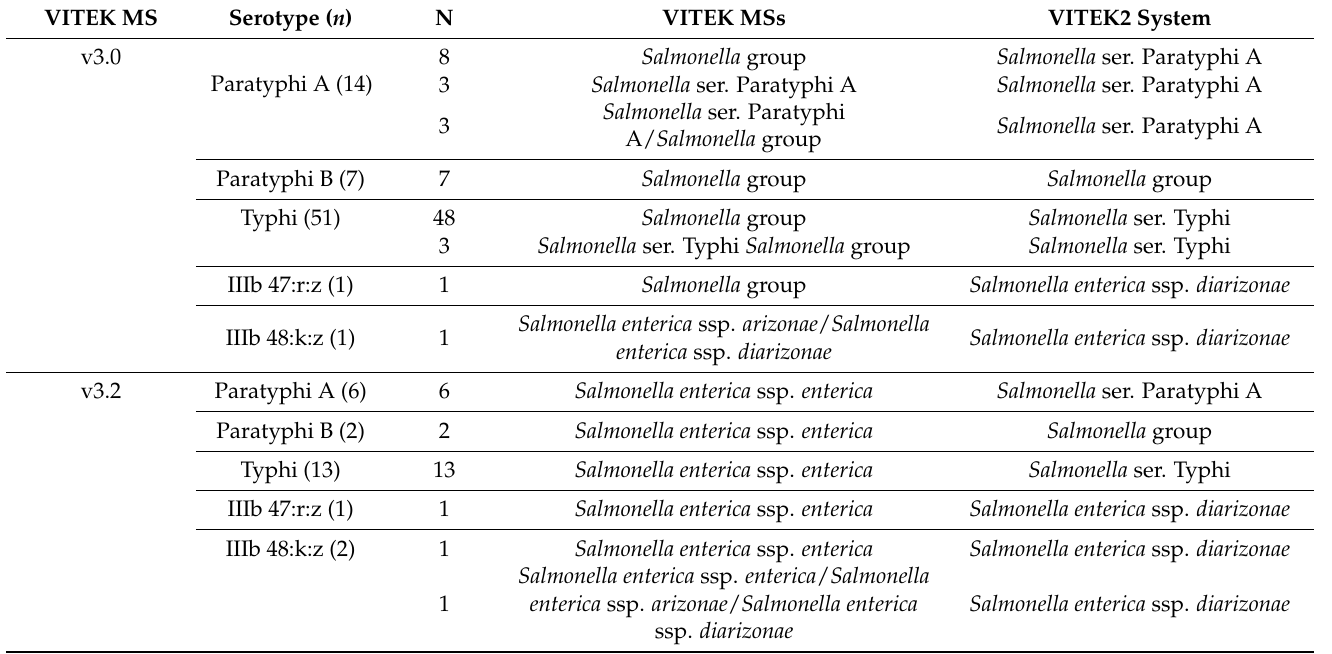
Table 4. Comparison between the performance of VITEK MS and VITEK2 systems in identifying serotype or